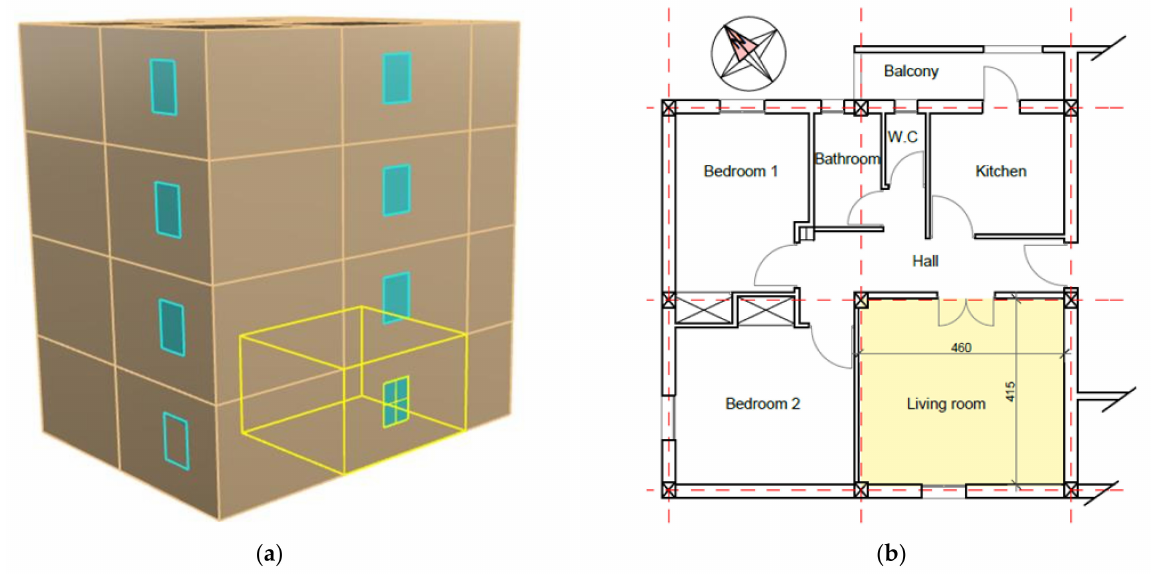
Figure 3. Case study ( a ) 3D and ( b )